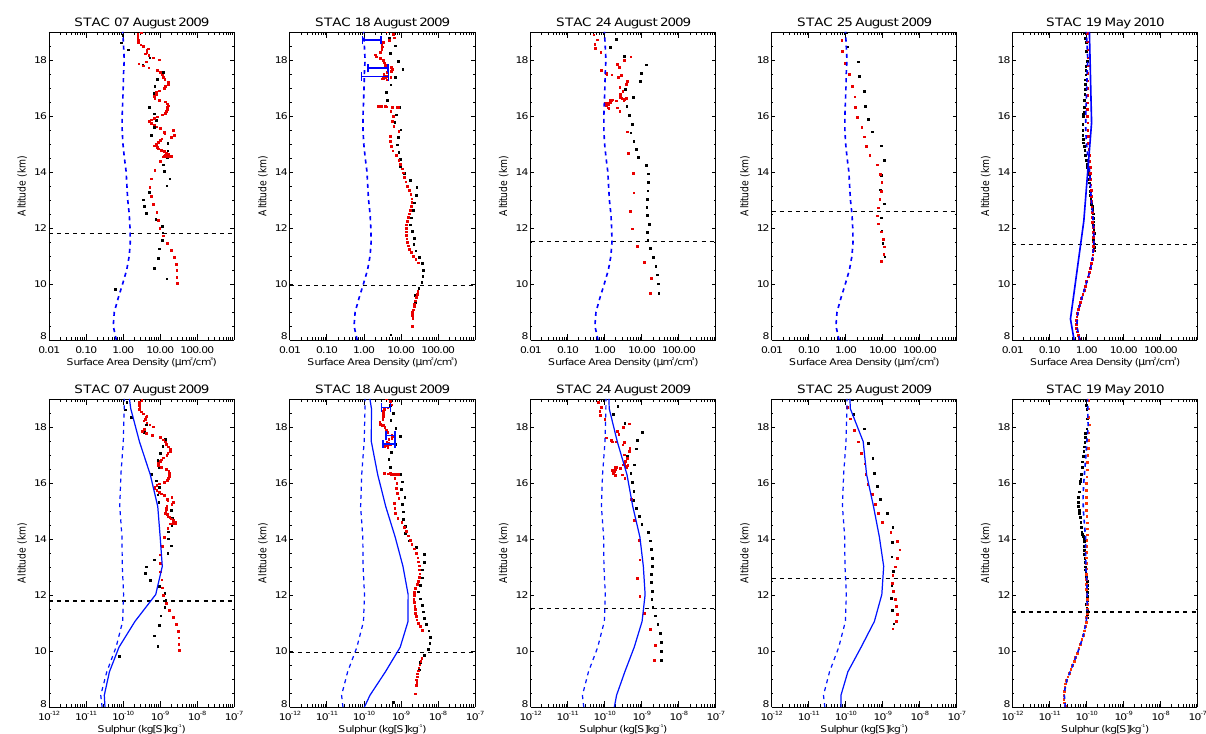
Fig. 12. Observations by the STAC aerosol counter for SAD (top) and sulphur mass (bottom) on 7, 18, 24 and 25 August 2009 (volcanic conditions) and on 19 May 2010 (background conditions), for the balloon ascent (black squares) and descent (red squares) balloon flights. Dashed blue lines: STAC background profiles on 19 May 2010 averaged over the whole flight (ascent and descent). Horizontal blue lines: MicroRADIBAL SAD and sulphur mass in the 17-19 km range on 18 August 2009. Sulphur mass: full blue lines correspond to the HadGEM2 profiles added to the 19 May 2010 STAC background profile. SAD: full blue line on 19 May 2010 is the typical SPARC ASAP scenario background aerosol profile (Weisenstein and Bekki, 2006). Horizontal black dotted lines: thermal tropopause derived from collocated balloon soundings. See section 6 for uncertainties.